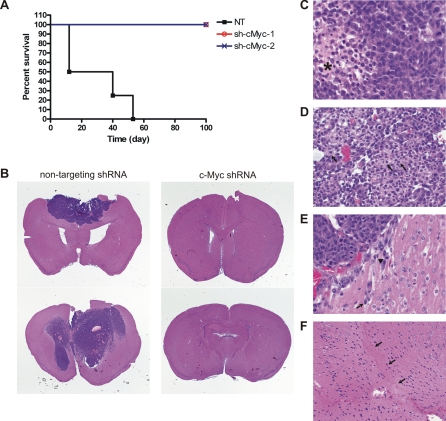
c-Myc knockdown abolishes xenograft tumor formation by glioma cancer stem cells.(A) T3359 CD133+ cells were infected and selected as described. After selection, cells were injected into brains of athymic BALB/c nu/nu mice (5000 cells per mouse). Four mice were injected for each group. Mice in the control group were sacrificed upon the development of neurologic signs. All the mice bearing c-Myc knockdown glioma cells did not develop neurologic signs and were sacrificed after 100 days without evidence of tumor. Kaplan-Meier survival curves are displayed. (B) Representative photographs of hematoxylin and eosin staining of intracranial xenograft tumors (10×). (C) Xenograft tissue of the control group composed of pleomorphic cells featuring high nuclear to cytoplasmic ratios, prominent nucleoli with minimal cytoplasm, brisk mitotic activity and central geographic necrosis (asterisk, 600×). (D) The control glioma xenograft exhibited focal areas of better differentiated tumor cells with relatively more eosinophilic cytoplasm and cells with eccentric cytoplasmic profiles suggestive of a gemistocytic appearance (arrows, 400×). (E) Xenograft tumor of the control group exhibits infiltration of tumor cells into the surrounding brain tissue along the margin. The mitotically active (arrowhead) infiltrating tumor cells exhibit high nuclear to cytoplasmic ratios and elongated fibrillar cytoplasm (arrow) (600×). (F) Mouse brain injected with T3359 cells expressing c-Myc shRNA showed no evidence of tumor at the needle injection site (arrows, 200×).